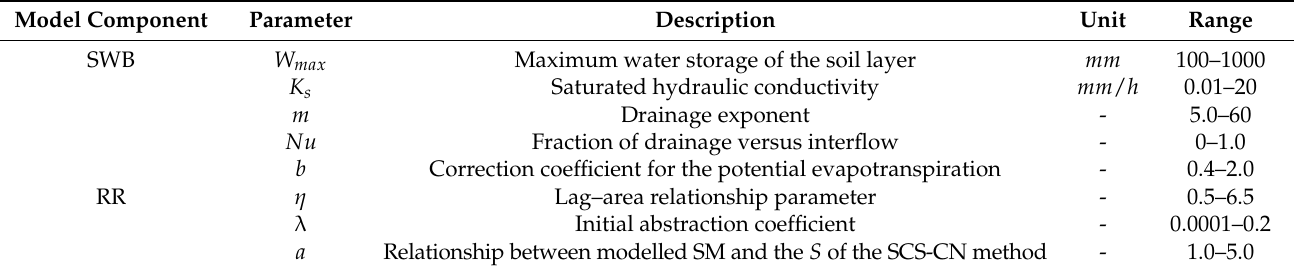
Table 1. Description of MISDc model calibration parameters, units and